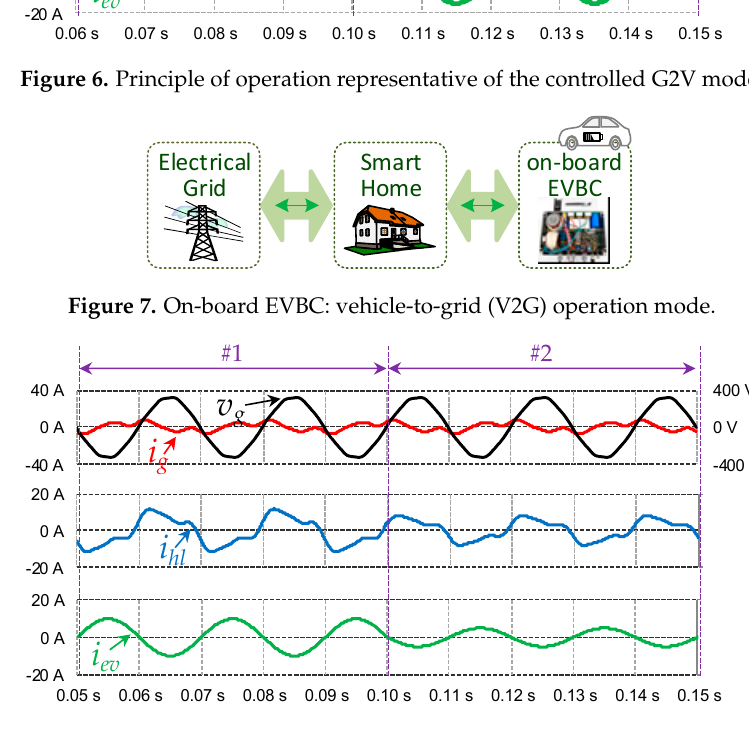
Figure 8. The principle of operation representative of the V2G mode.